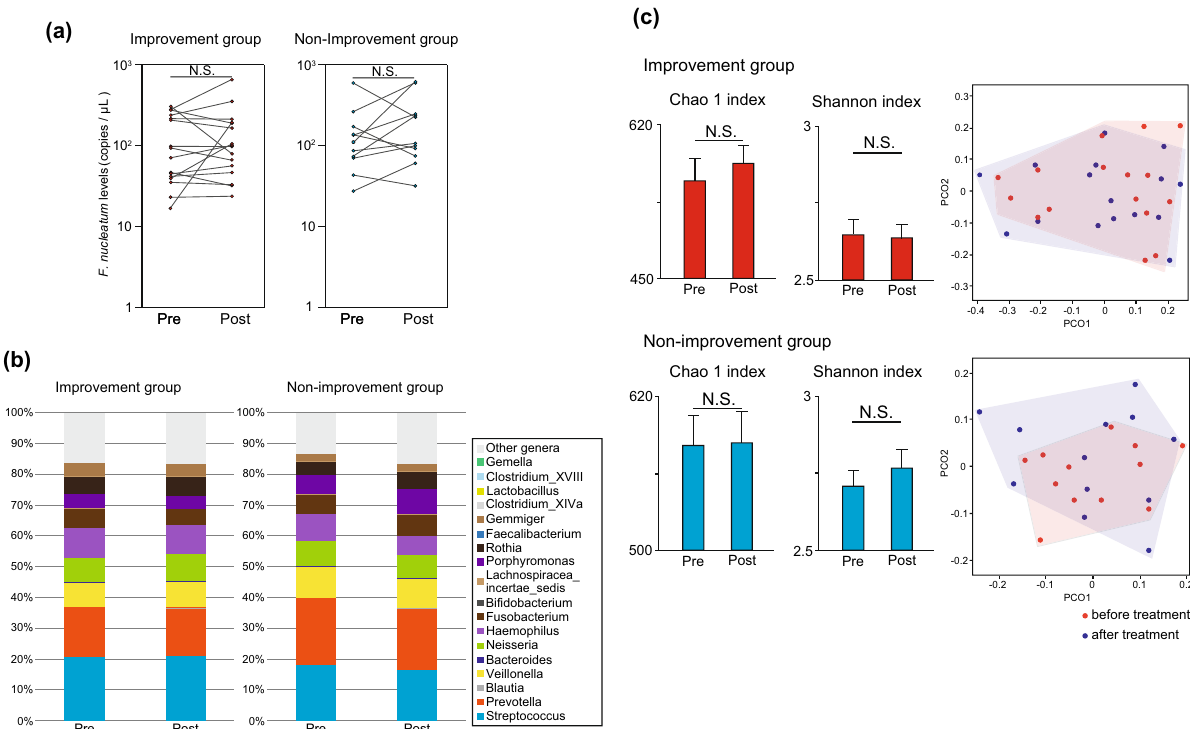
Figure 4. Analysis of Fusobacterium nucleatum DNA levels and bacterial flora in saliva. ( a ) F. nucleatum DNA levels in the saliva before and after periodontal treatment (n = 16, 11). ( b ) Changes in the bacterial composition of saliva before and after treatment for periodontitis. ( c ) Changes in the diversity of the bacterial flora in saliva. Data are means ± SEM. Paired Student’s t -test, PCoA analysis with the R Software ( c